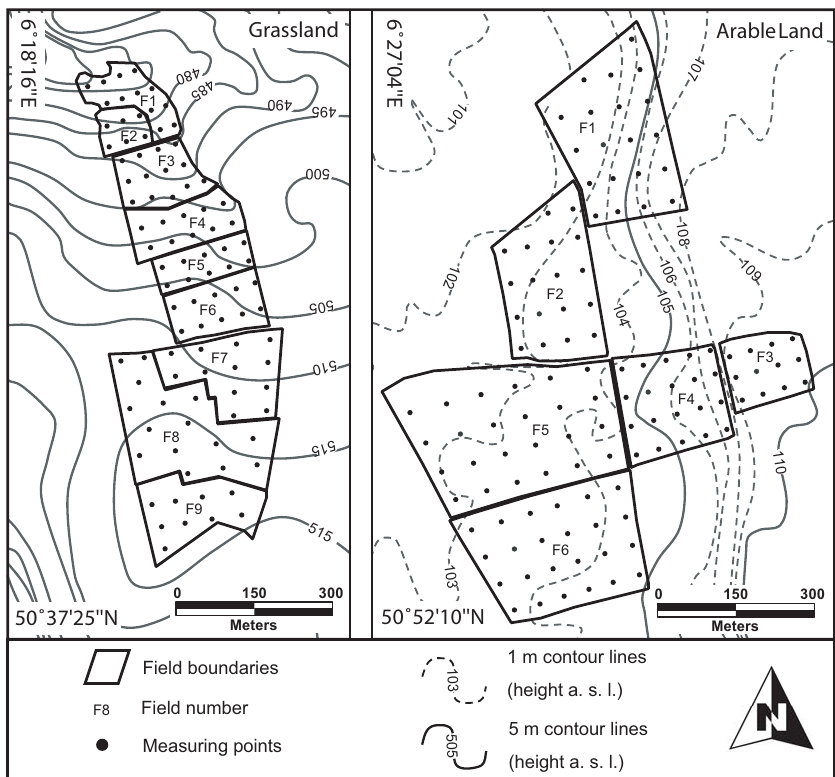
Figure 1. Topography, field layout and measuring grid of the grassland (Rollesbroich) and the arable test site (Selhausen).